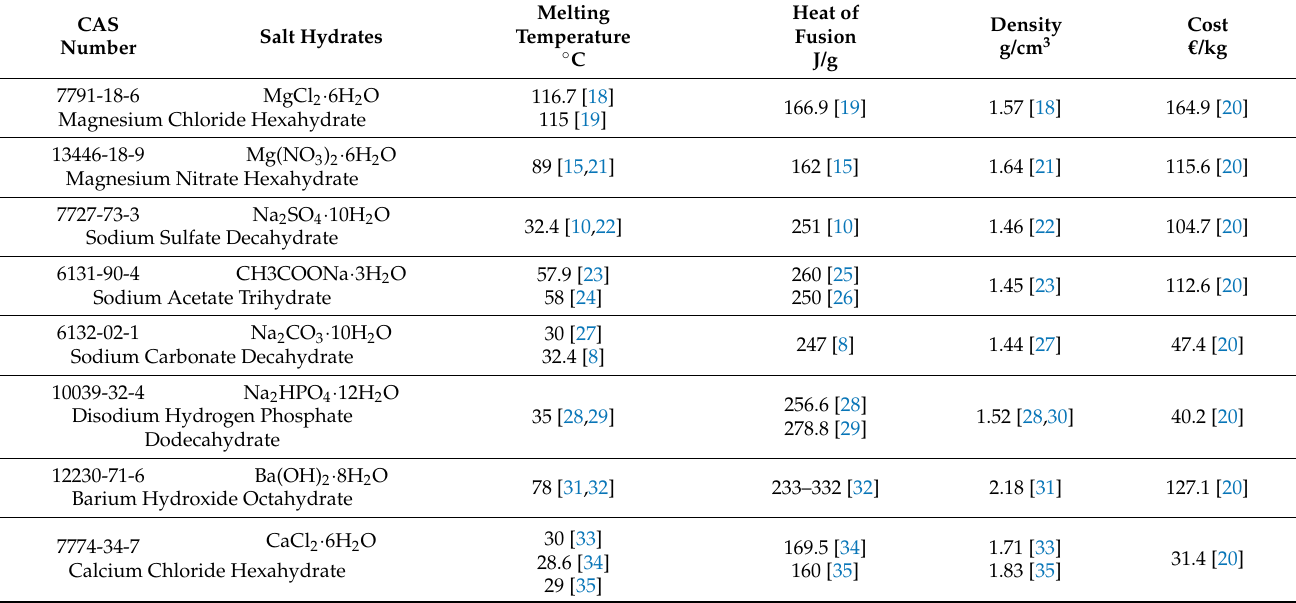
Table 1. Thermophysical parameters of salt hydrates for use in solar installations and their